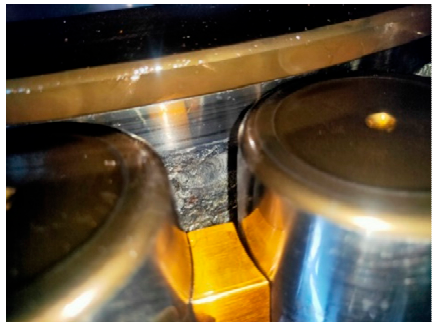
Figure 11. The fault occurring on the inner race of the engineering bearing. Table 1. Measured amplitudes of the four measuring points.